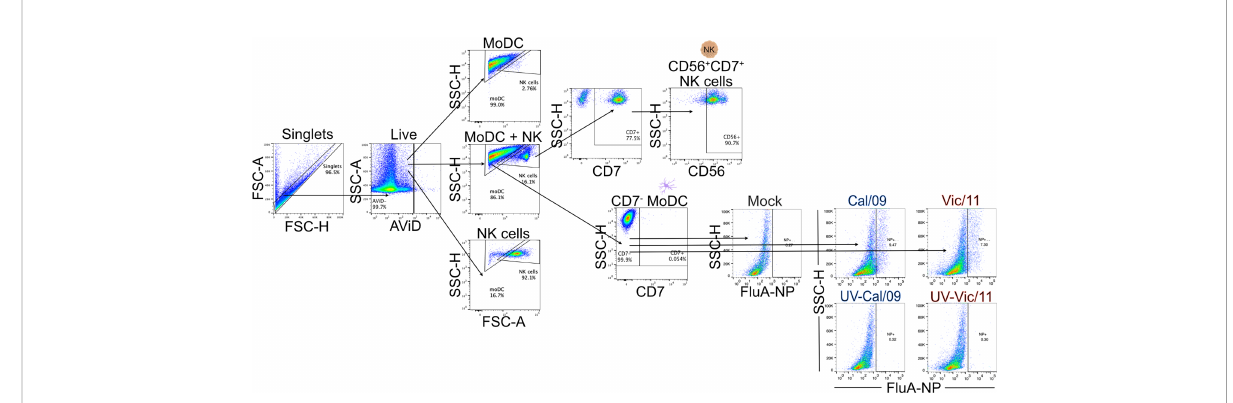
FIGURE 1 Lineage gating schematic for MoDCs and NK cells. Diagram of lineage gating tree used to identify MoDCs and NK cells by fl ow cytometry. MoDCs and NK cells were separated into gates by size and granularity using forward and side scatter. MoDCs were further identi fi ed as CD7 - while NK cells were identi fi ed as CD7 + CD56 + . Cal/09 and Vic/11 infection of MoDCs at an MOI of 3 at 24 HPI is shown using an antibody speci fi c to IAV nucleoprotein (FluA-NP). AViD, LIVE/DEAD Fixable Violet Dead Cell Stain; FSC, forward scatter; SSC, side